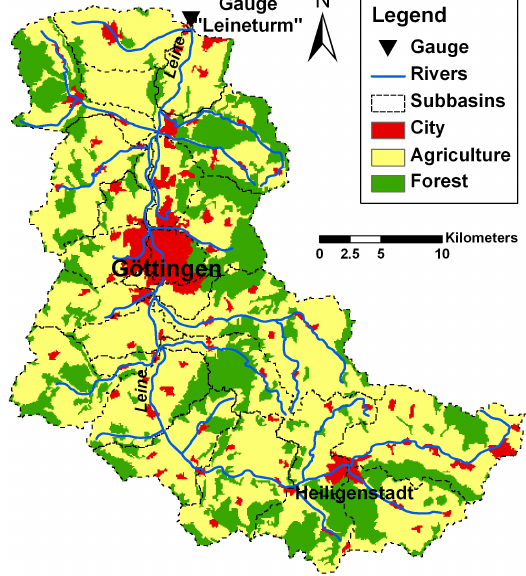
Fig. 1. Overview of the upper Leine catchment with major land use and river